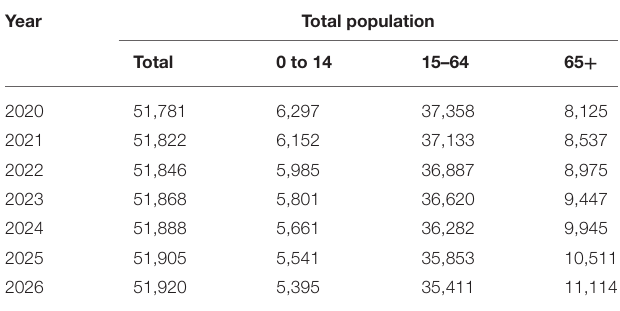
TABLE 6 | Future Korean population and elderly population estimation.